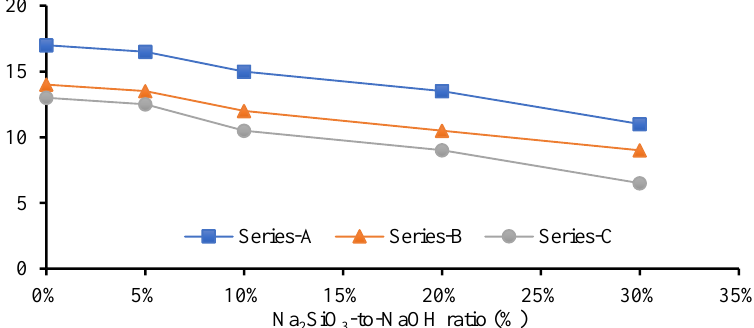
Figure 13. Compressive strength test results for the geopolymer specimen using various Na2SiO3- to-NaOH and FA-to-GGBS ratios with sand preheated at 110 °C and cured in a hot oven at a uniform temperature of 50 °C for 3 h.